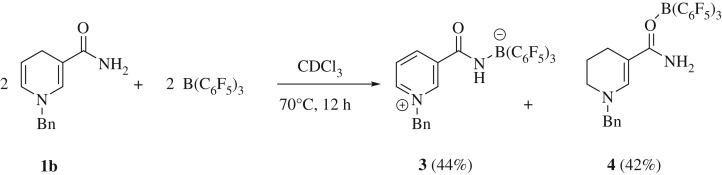
Reaction between 1b and B(C6F5)3 to give 1 : 1 mixture of 3 and 4.